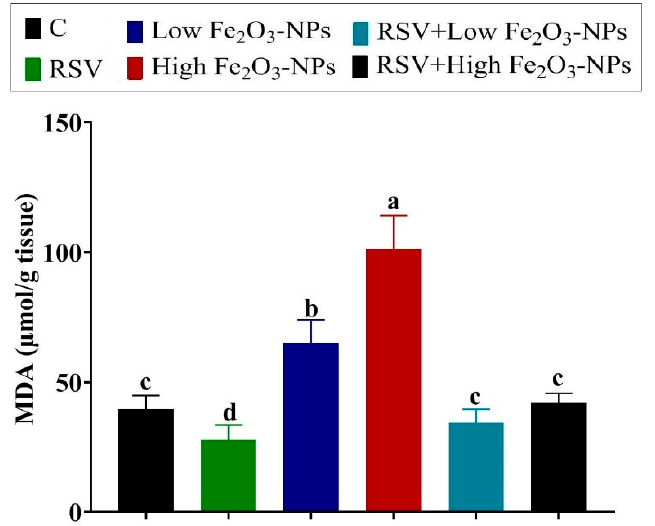
Figure 5. Effect of resveratrol (RSV; 20 mg/kg b.wt) and/or iron oxide nanoparticles (Fe 2 O 3 -NPs 3.5 or 7 mg/kg b.wt) administration for eight weeks on malondialdehyde (MDA) levels in the testicular tissues of male rats. Data expressed as mean ± SD, n = 9 for each group. Different letters (a, b, c, and d) on columns indicate statistically significant differences at p < 0.05 between the different experimental groups.